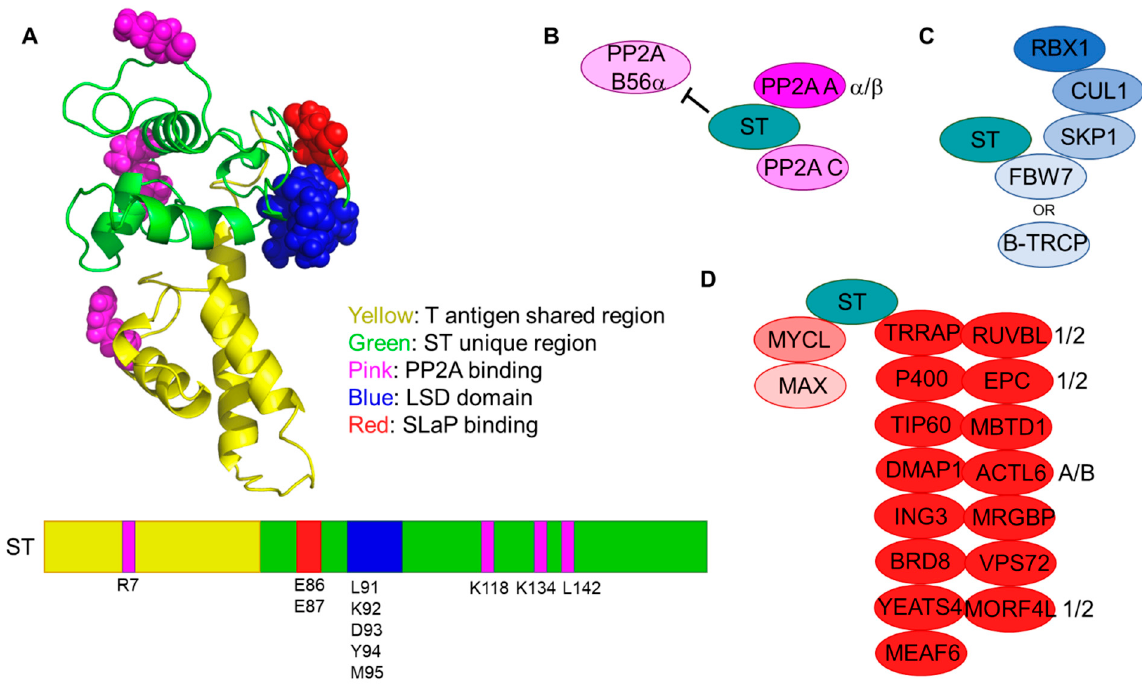
Figure 3. The domains and binding partners of MCV ST. ( A ) The structure of MCV ST was modeled by threading the MCV ST sequence onto the SV40 ST crystal structure (PDB ID: 2PF4) using the I-TASSER server [105–108] and regions of interest were highlighted. ( B–D ) Cartoons of the major ST-containing cellular complexes: ( B ) PP2A; ( C ) SCF(FBW7) and SCF(B-TRCP); ( D ) SLaP: ST, MYCL, and P400 complex.